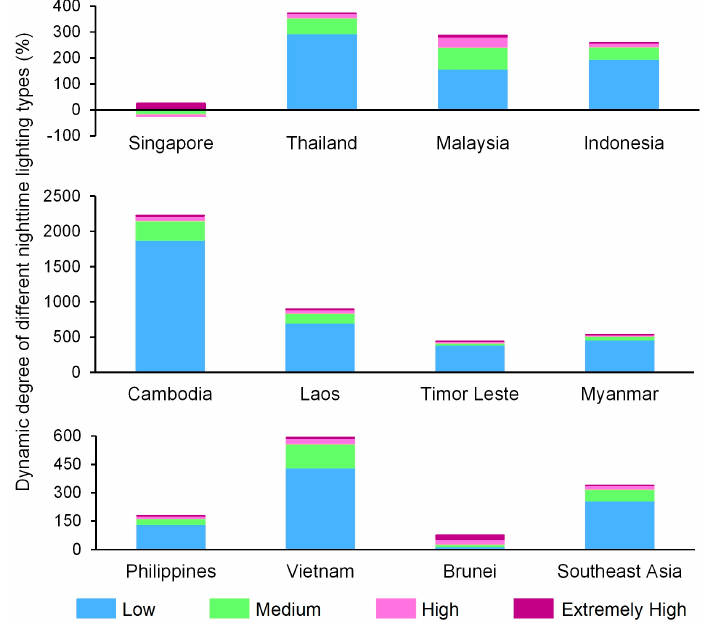
Figure 7. Dynamic degrees in different types of nighttime lighting areas across Southeast Asia between 1992 and